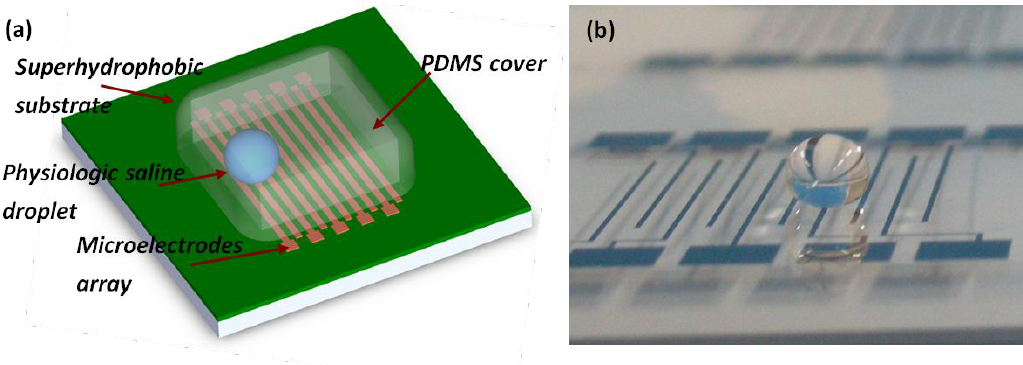
Figure 8. Liquid droplet based accelerometer. (a) the schematic view; and (b) a prototype without the PDMS